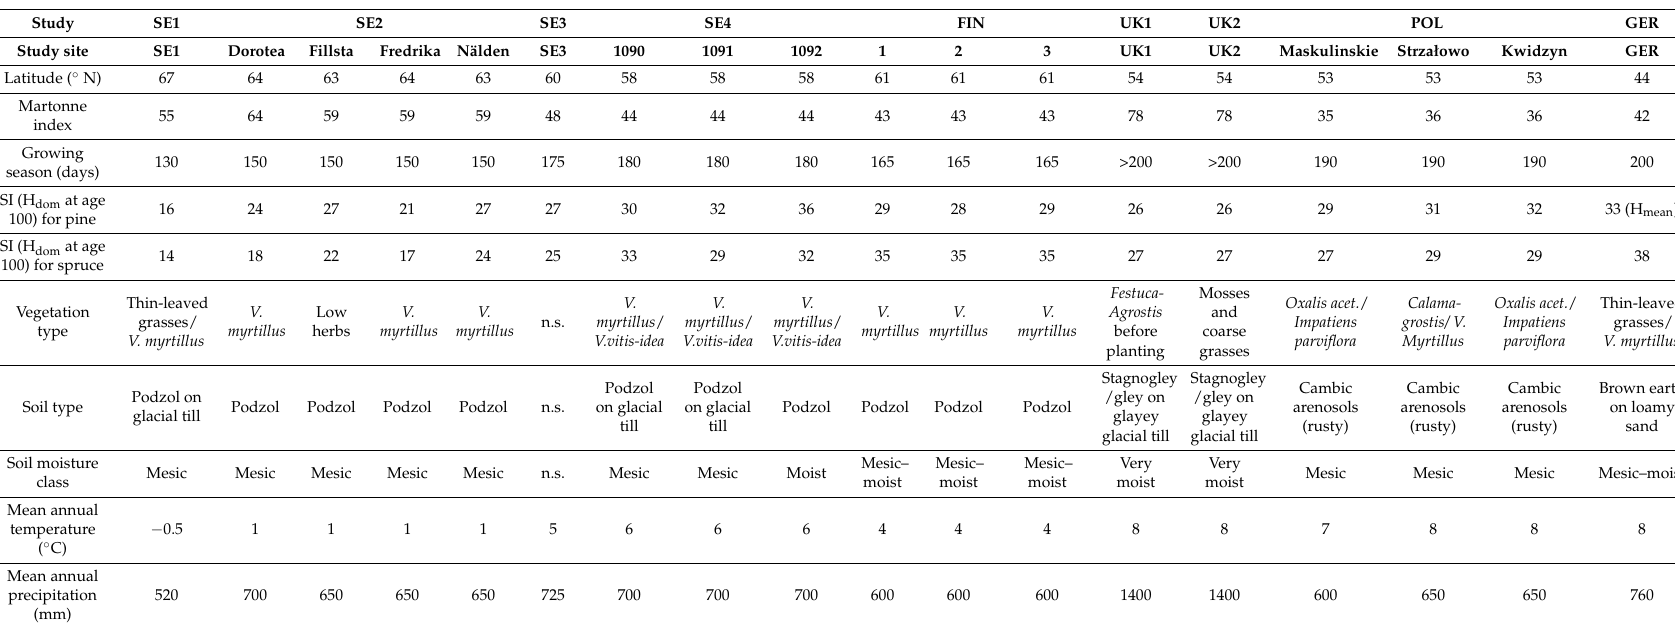
Table 3. Selected site and stand characteristics of the 18 study sites within the nine study areas. The site index SI was calculated specifically describing dominant trees in monospecific stands in each country, using the methods by Hägglund and Lundmark [34] for Swedish sites, by Edwards and Christie [35] for the site in the UK, by Hynynen et al. [21] for the Finnish site, Assmann and Franz [36] and Wiedemann [37] for the German site, and Bruchwald [38] for Polish